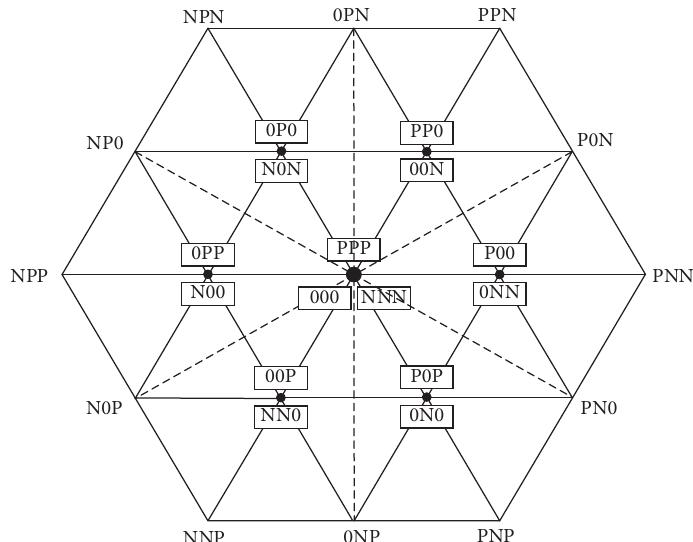
Figure 2: Distribution diagram of space vectors in αβ reference frame.